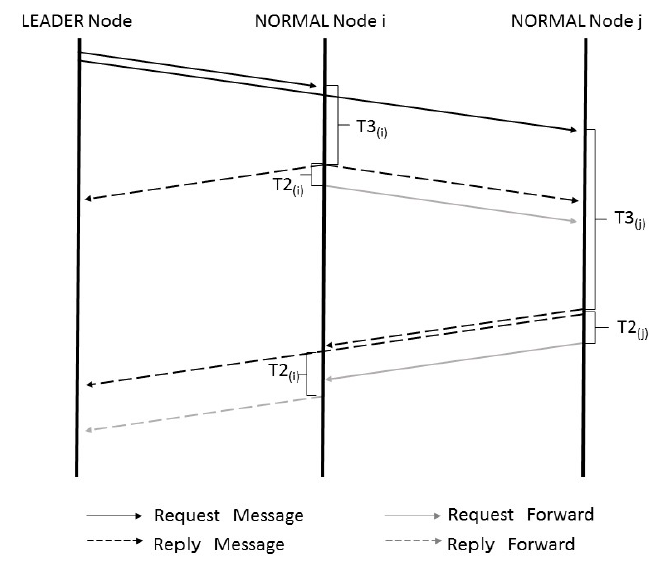
Figure 8. Message transmission sequence of the collision avoidance method using the request-response-type stray node detection protocol.